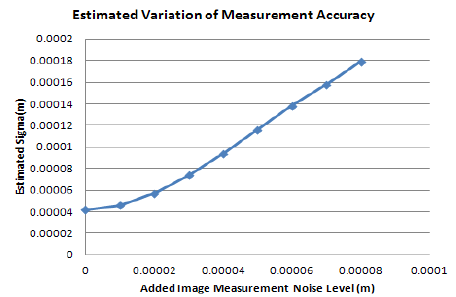
Figure 7. Variation of measurement accuracy at different image measurement noise level